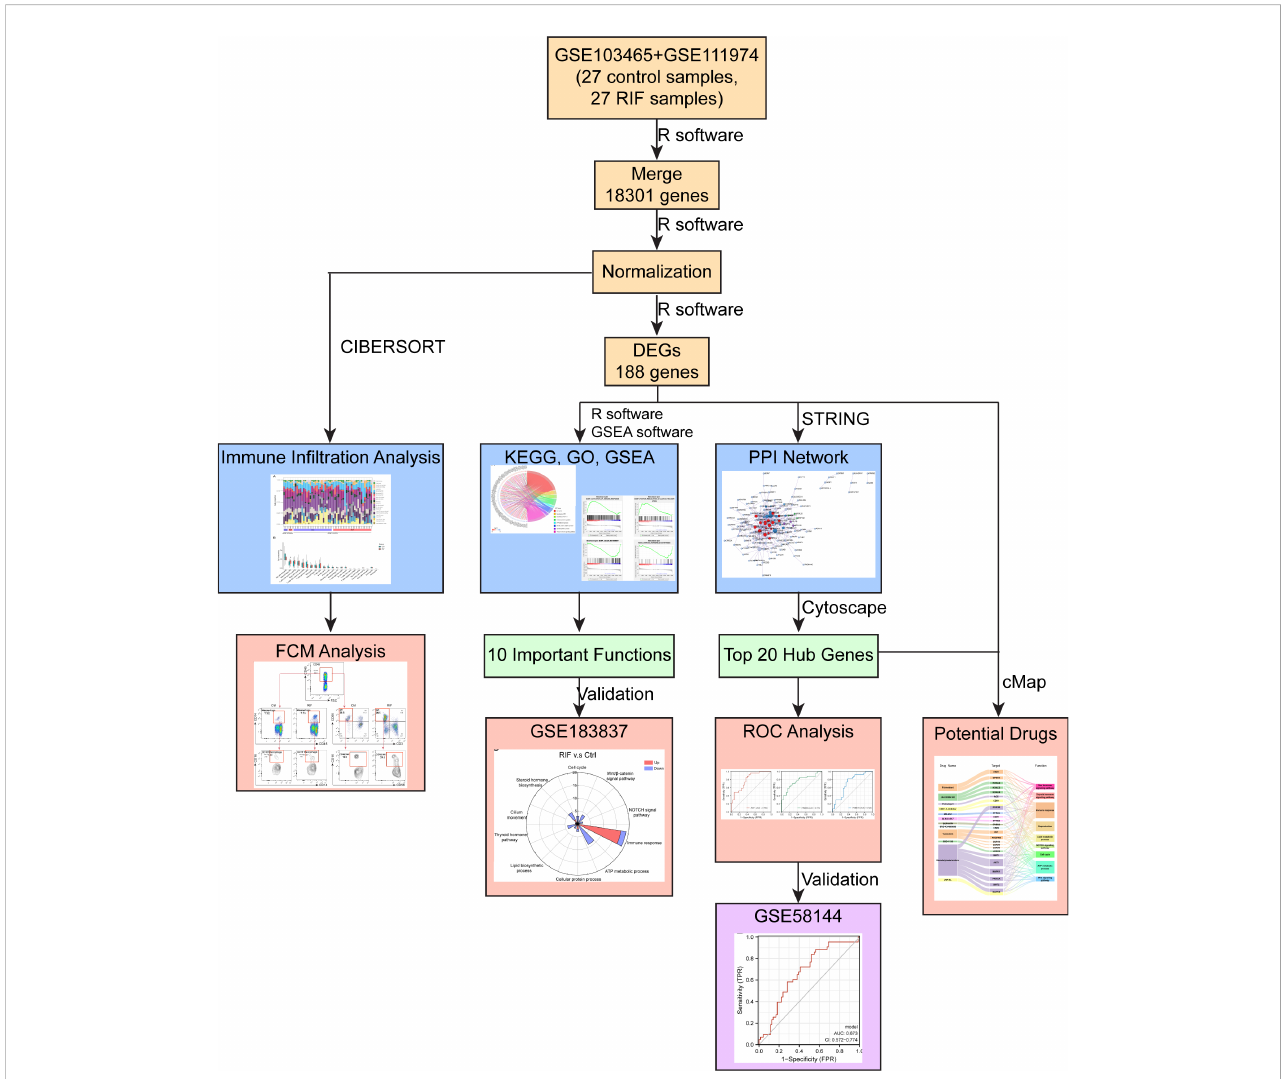
FIGURE 9 Diagram of the study design. Discover datasets, GSE103465, and GSE111974, contained 18301 genes with 27 RIF and 27 Ctrl samples. In total, 188 DEGs were identi fi ed: 122 genes were downregulated and 66 genes were upregulated. Ten important pathways related to RIF were enriched, and were validated by validation dataset (GSE183837). Top 20 hub genes were identi fi ed by Cytoscape through PPI network, and three of them may have potential predictive values for RIF in the validation set (GSE58144). Endometrial macrophages ’ in fi ltration level was increased in patients with RIF, compared to the control group, which were performed by CIBERSORT algorithm, and validated by FCM analysis. Bisindolylmaleimide-ix and JNK-9L may be potential therapeutic compounds for RIF, related to the result of cMap